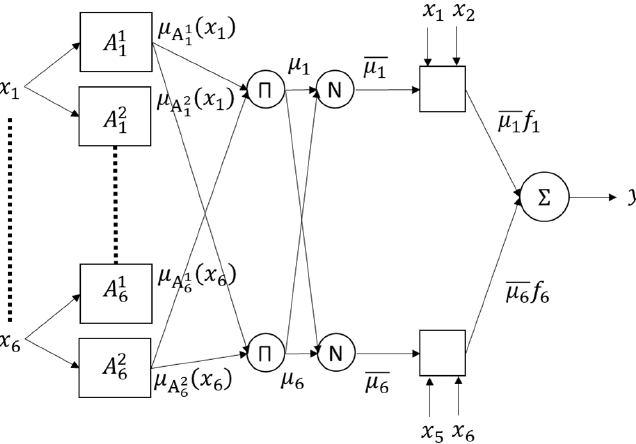
Figure 2. Architecture of ANFIS model equivalent to the inference